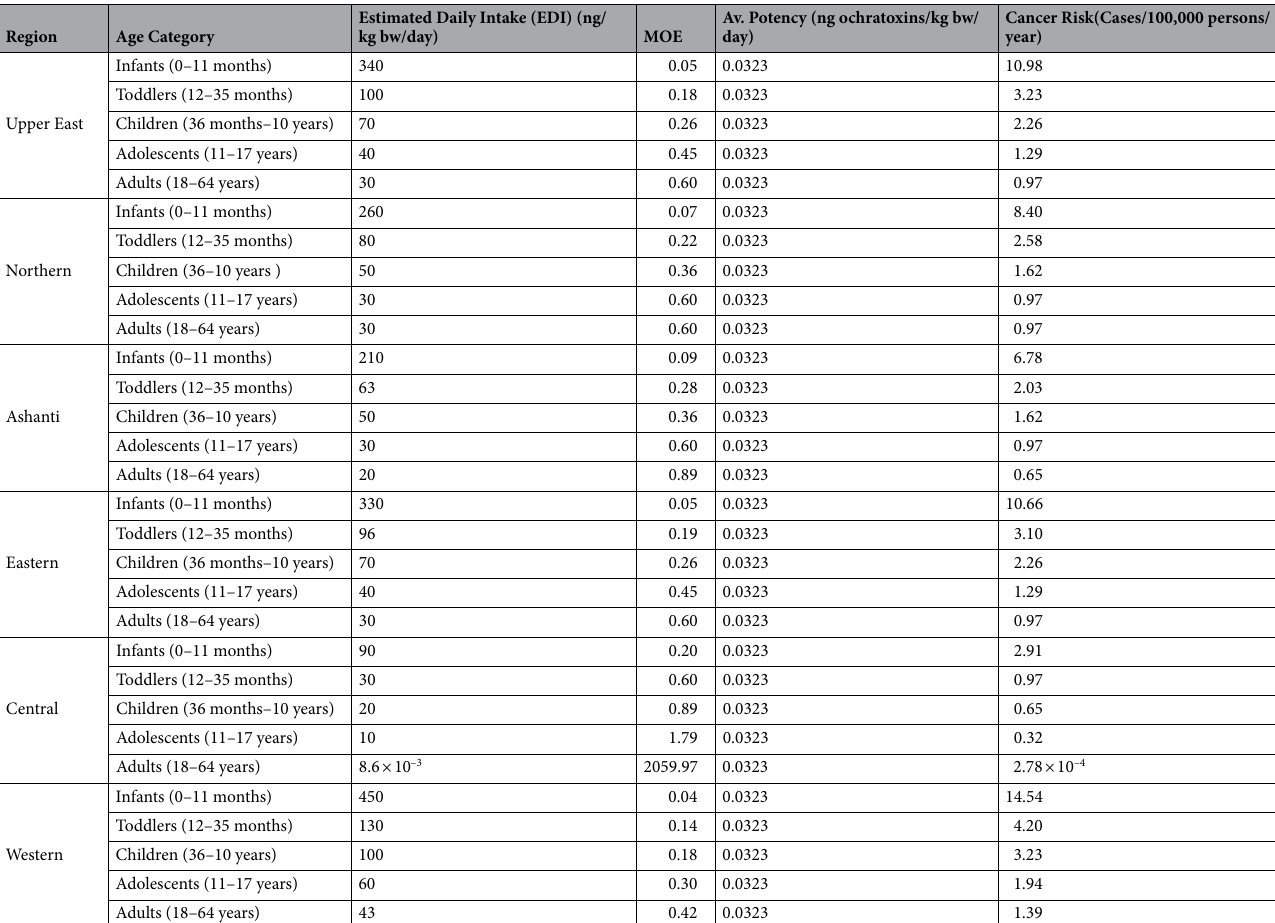
Table 17. Evaluation of risk for Ochratoxin A (OTA) via consumption of maize. Margin of Exposure- MOE. Mean ochratoxin A- Upper East = 18.22 µg/kg, Northern = 14.14 µg/kg, Ashanti = 11.52